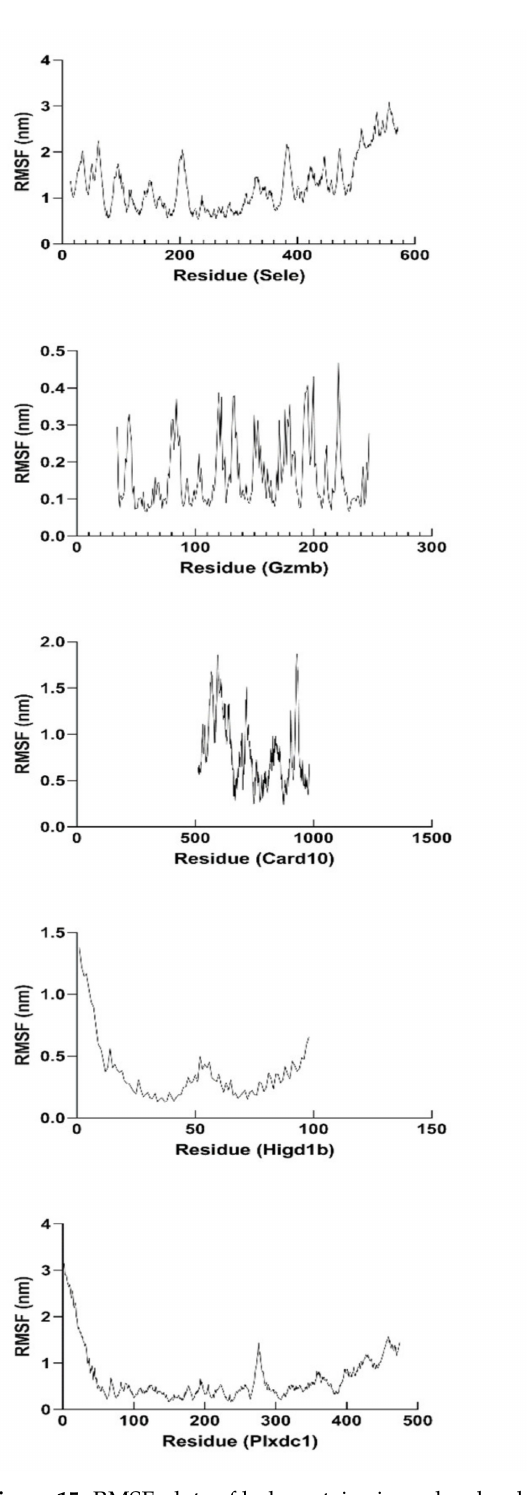
Figure 15. RMSF plots of hub proteins in molecular dynamics simulation (300 ns). The RMSF of SELE, 9930111J21RIK2, GZMB, LPAR3, CARD10, PLEKHH3, HIGD1B, GM12689, PLXDC1, and PKN3 were